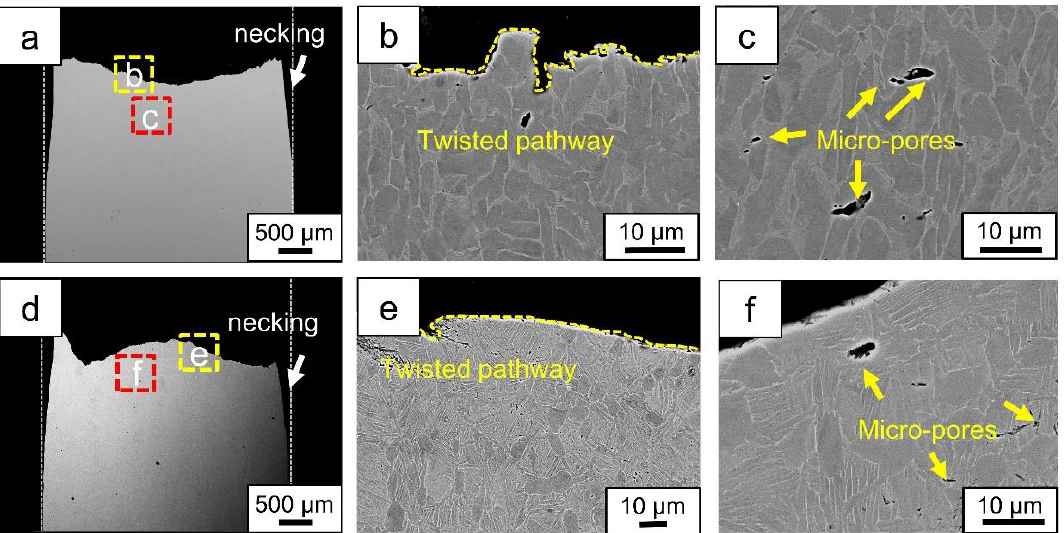
Figure 8. Longitudinal cross-section of the fractured LD-Ti423 alloy with different magnifications. Red and yellow dashed rectangles represent areas characterized with larger magnification. ( a – c ) HR condition; ( d – f ) HR+STA condition.